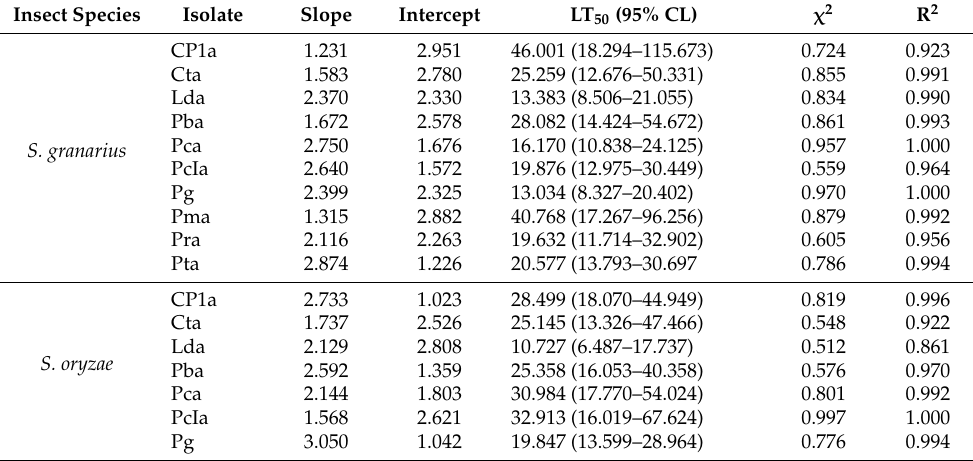
Table 2. Lethal time (LT 50 ) and associated probit parameters of tested adults treated with conidial suspension at 10 8 conidia/mL by several species of entomopathogenic fungi for a period of 7, 14, and 21